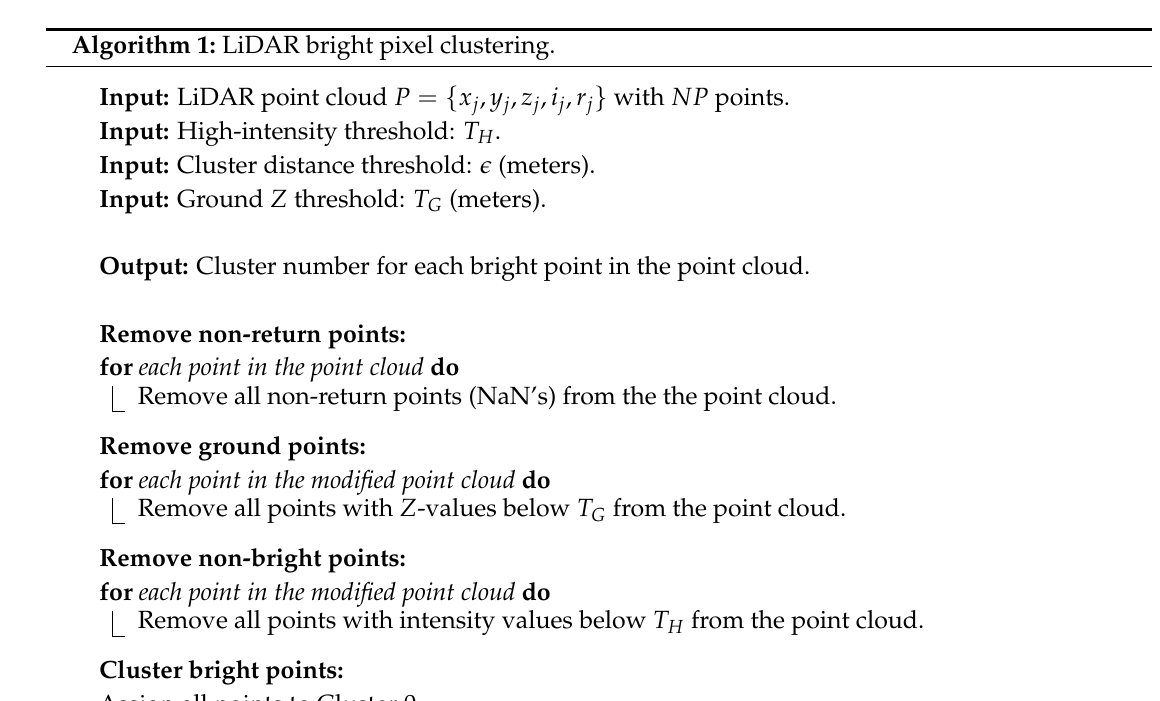
Algorithm 1: LiDAR bright pixel